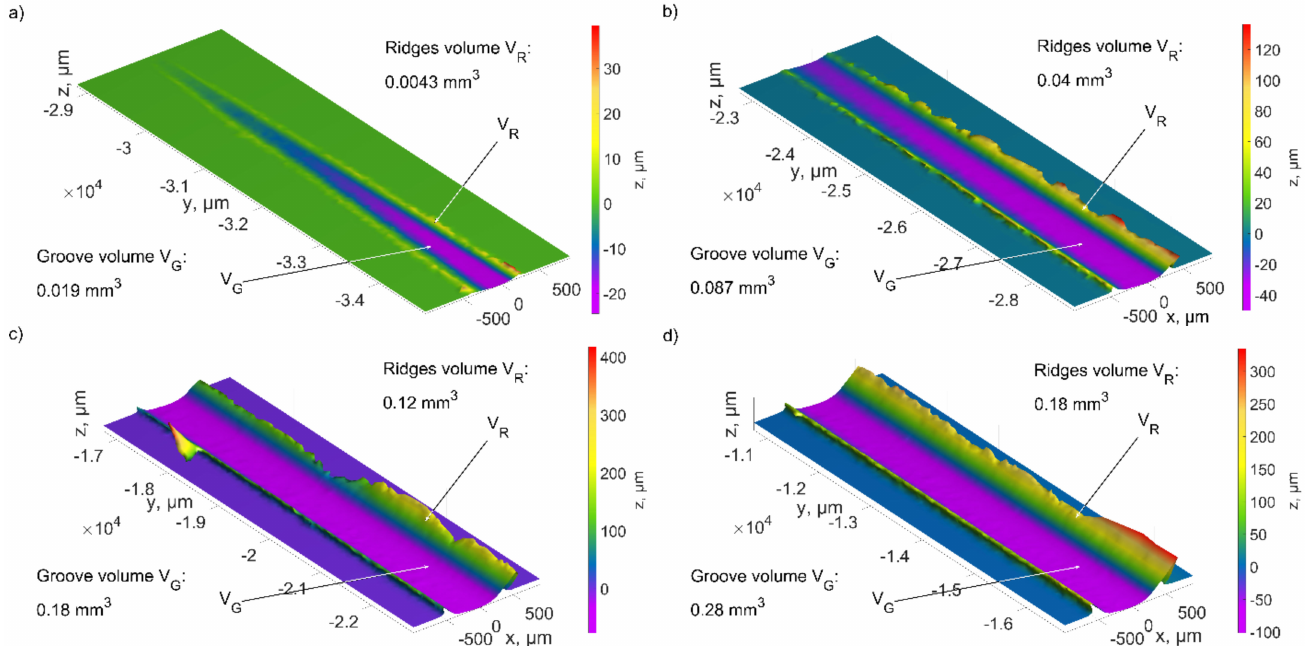
Figure 17. The results of the scratch volume and pile ups after the ZS3 grain cutting process for the depth of cut: ( a ) from 0 to 25 µ m, ( b ) from 25 µ m to 50 µ m, ( c ) from 50 µ m to 75 µ m, ( d ) 75 µ m to 100 µ